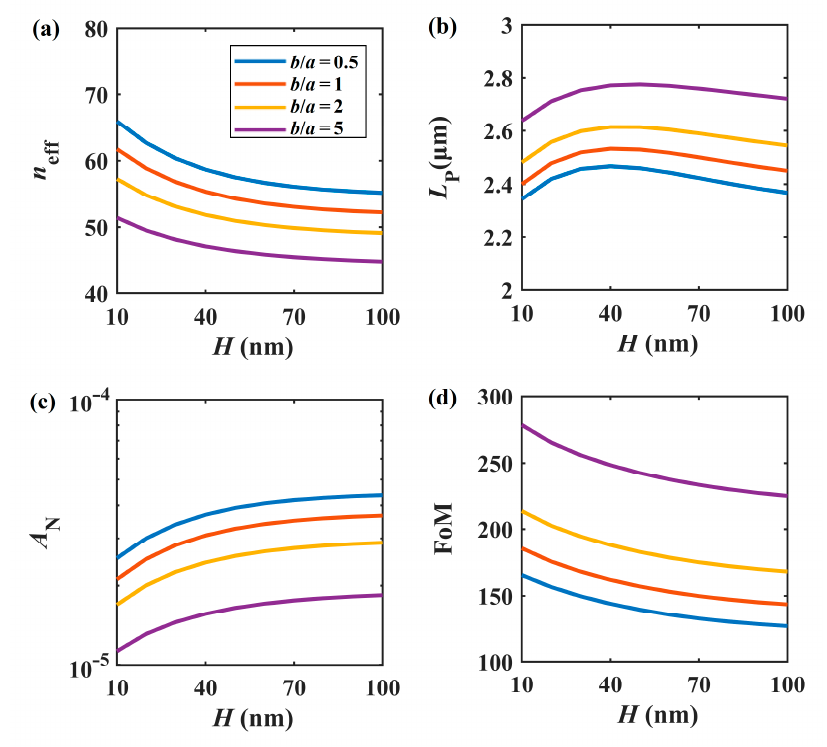
Figure 4. Modal properties of H at different b / a values. ( a ) n eff , ( b ) L P , ( c ) A N , ( d ) FoM.